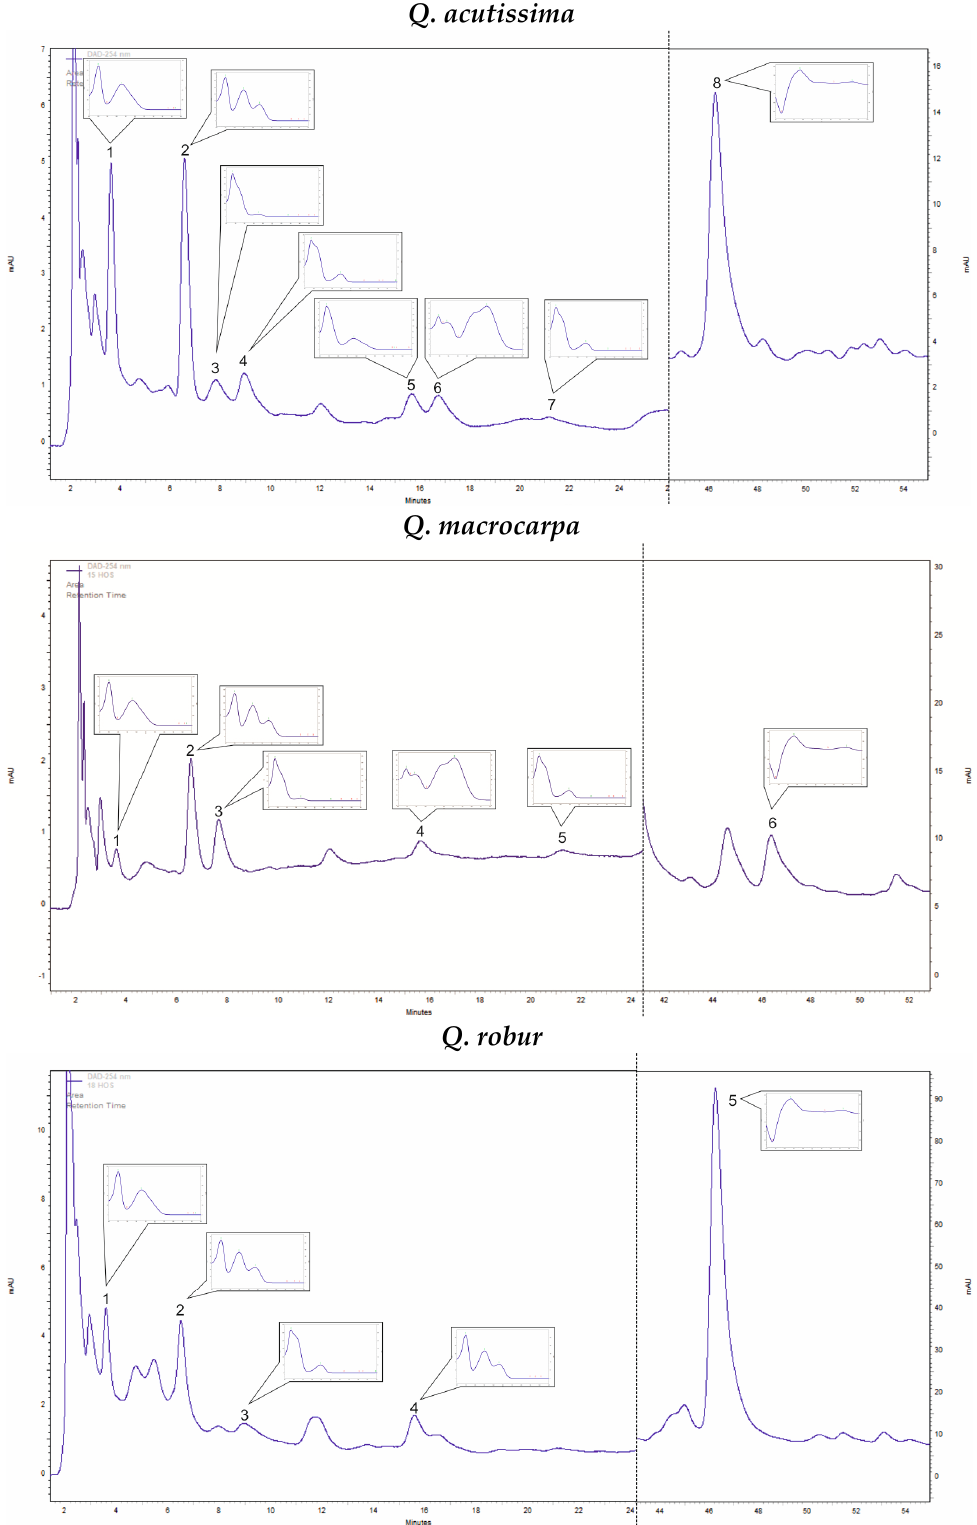
Figure 1. Representative of HPLC-DAD ( λ = 254 nm) chromatograms of Quercus ssp.